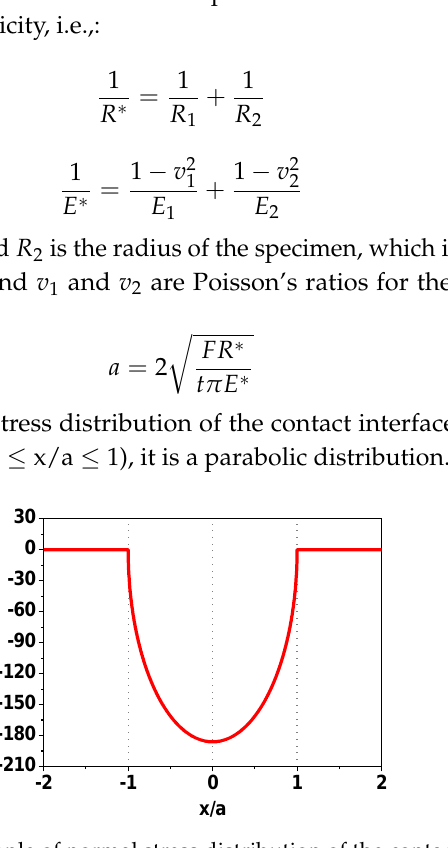
Figure 1. An example of normal stress distribution of the contact surface.